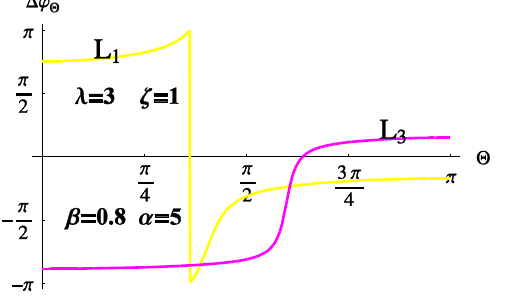
Fig. 3. The distribution of the differences of the amplitudes of the field tangent component of the own phase and the tangent component of the field outside (without the magnetic field of the own phase) of the outer phases of a three-phase single-pole flat high-current busduct with symmetrical currents I 1 , I 2 and I 3